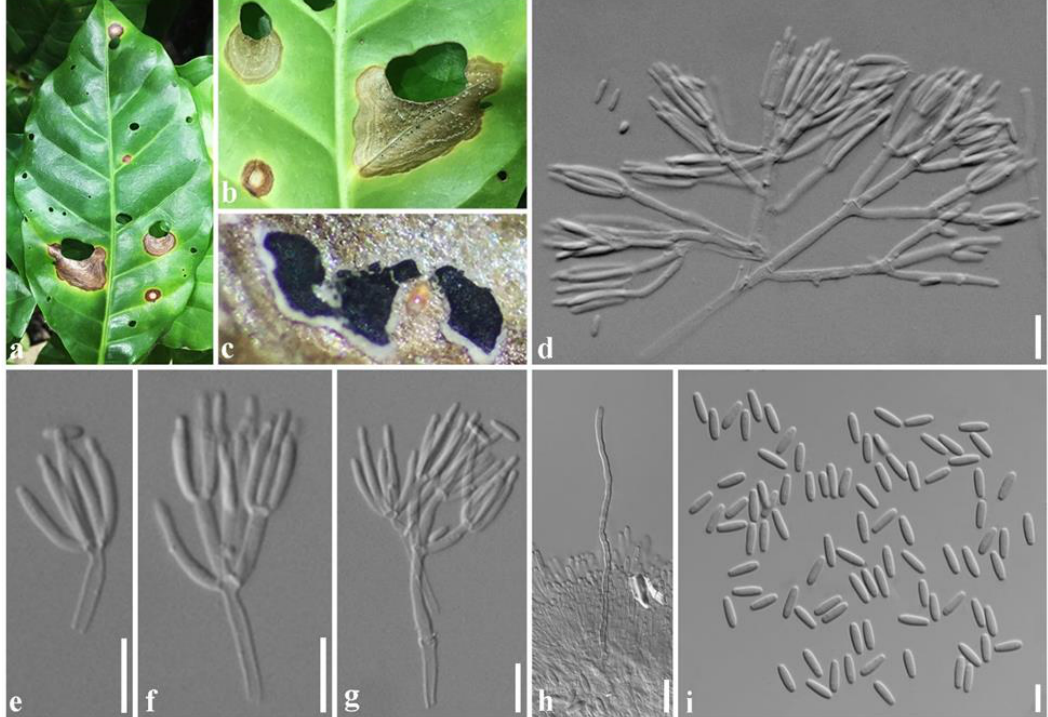
Figure 5. Paramyrothecium breviseta (CRC13-H); ( a , b ) leaf spot of Coffea arabica ; ( c ) sporodochia on leaf; ( d ) conidiophores and conidiogenous cells; ( e – g ) conidiogenous cells; ( h ) setae; ( i ) conidia. Scale bars: ( d ) = 20 µm; ( e – h ) = 10 µm; ( i ) = 5 µm. Culture characteristics: Colonies on PDA, dense, circular, flattened, slightly raised, floccose, white aerial mycelium, radiating with concentric ring of sporodochia forming, covered by slimy olivaceous green to black conidial masses.